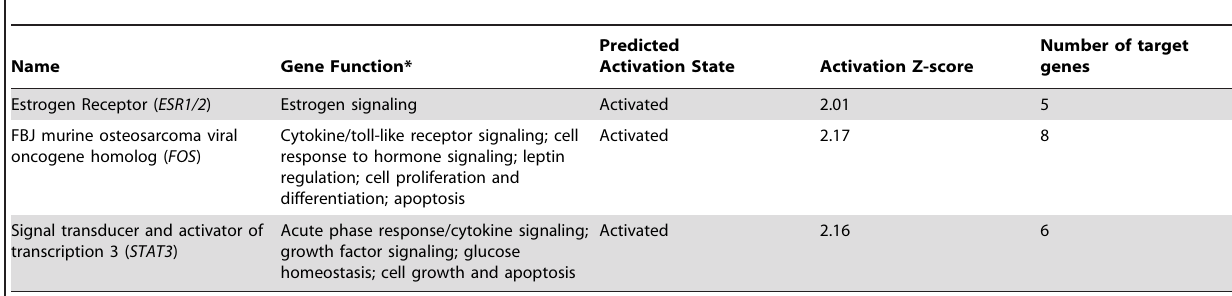
Table 6. Activated Upstream Regulators in Fetuses of Obese versus Lean